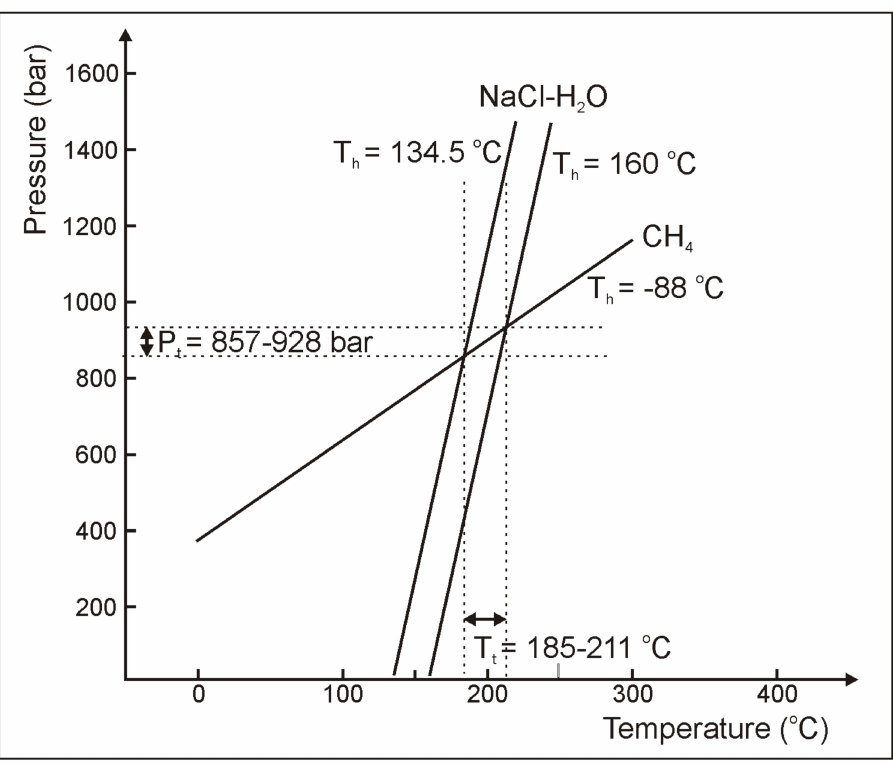
Figure 10. The estimation of P-T trapping conditions for AQFI (brine) and HCFI 1 (methane) in the Zakrzyn IG 1 borehole (depth 4905.4